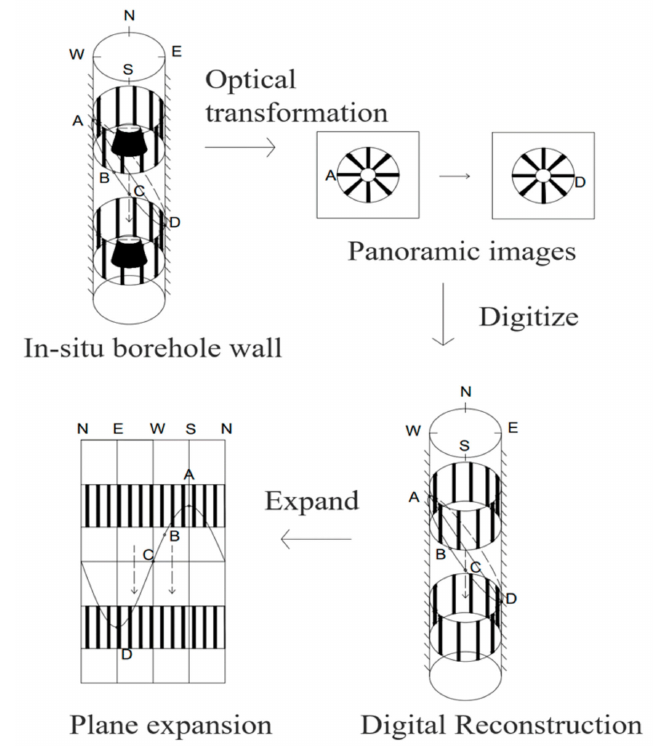
Figure 1. Digital panoramic borehole camera imaging